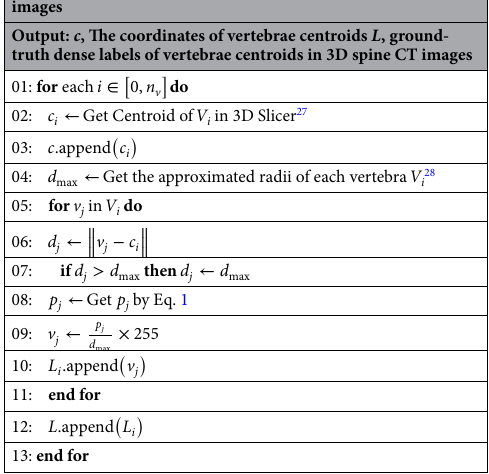
Table 1. Algorithm 1: Pseudocode of building dataset for vertebrae localization.